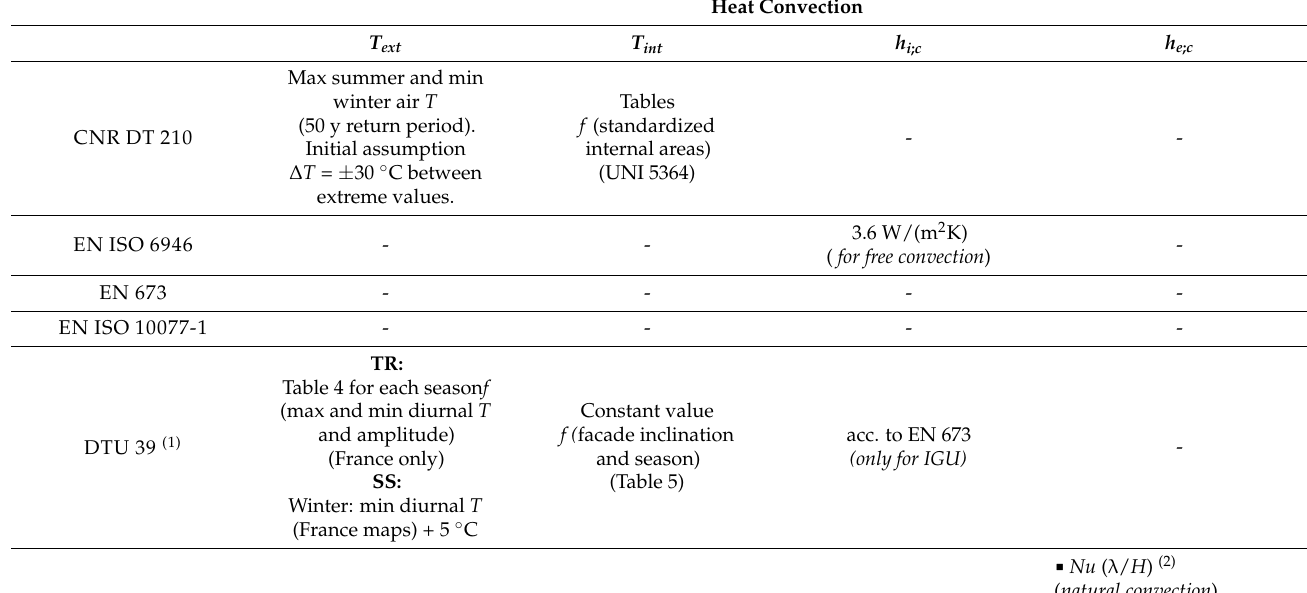
TR: Table 4 for each season